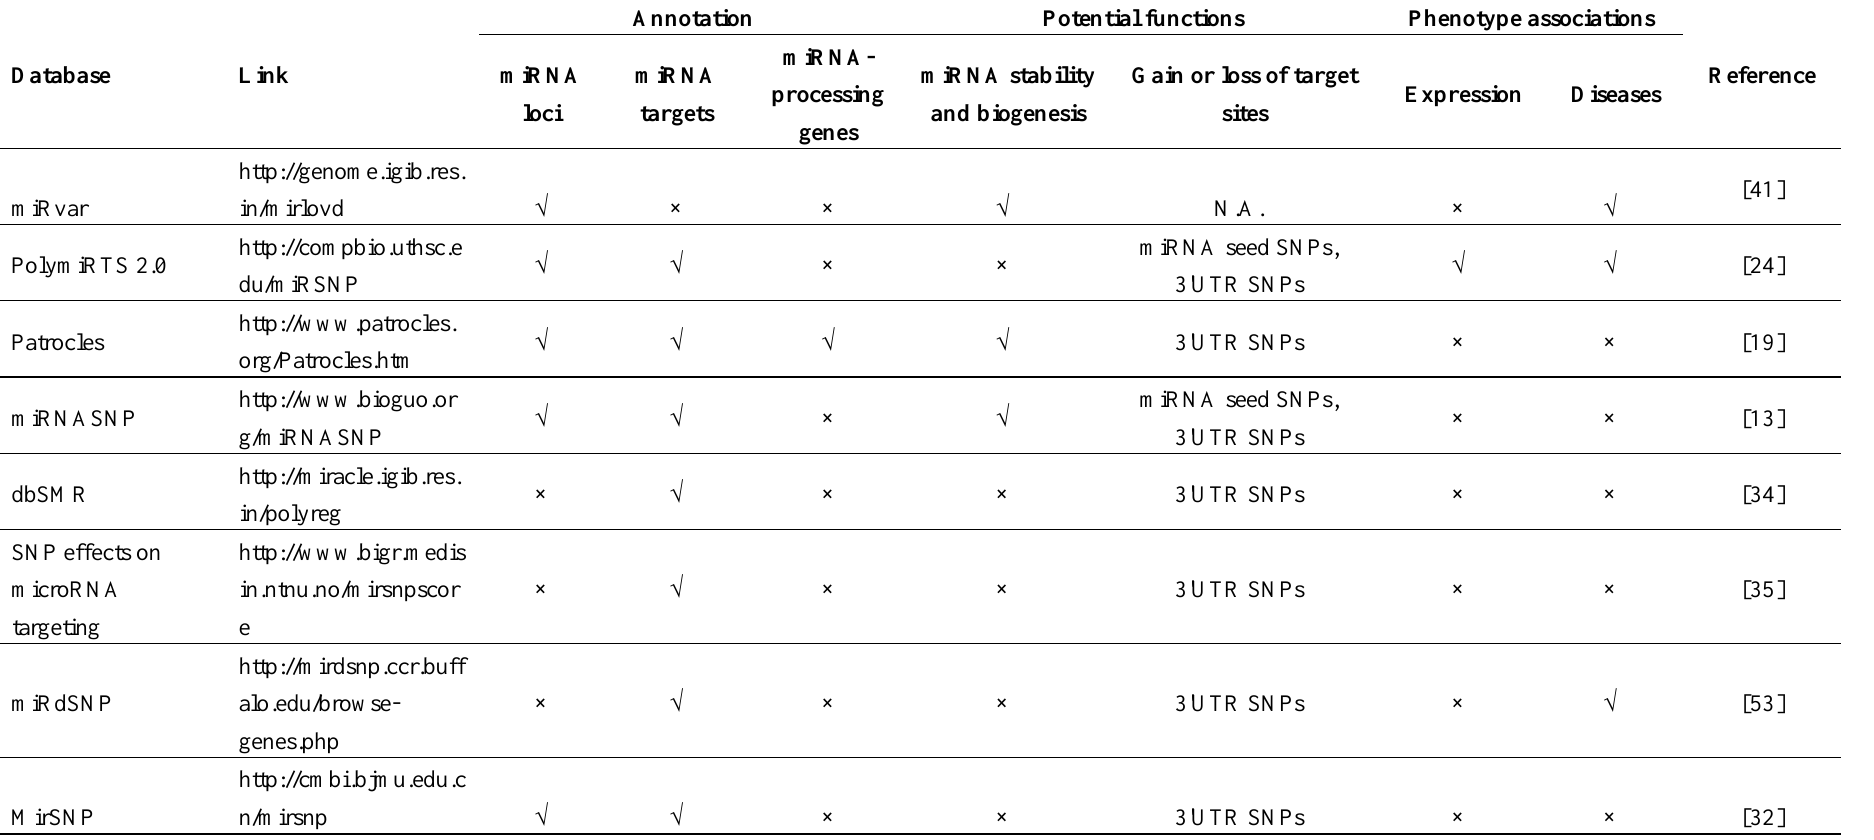
Table 4. Summary of Databases about MiRNA-associated